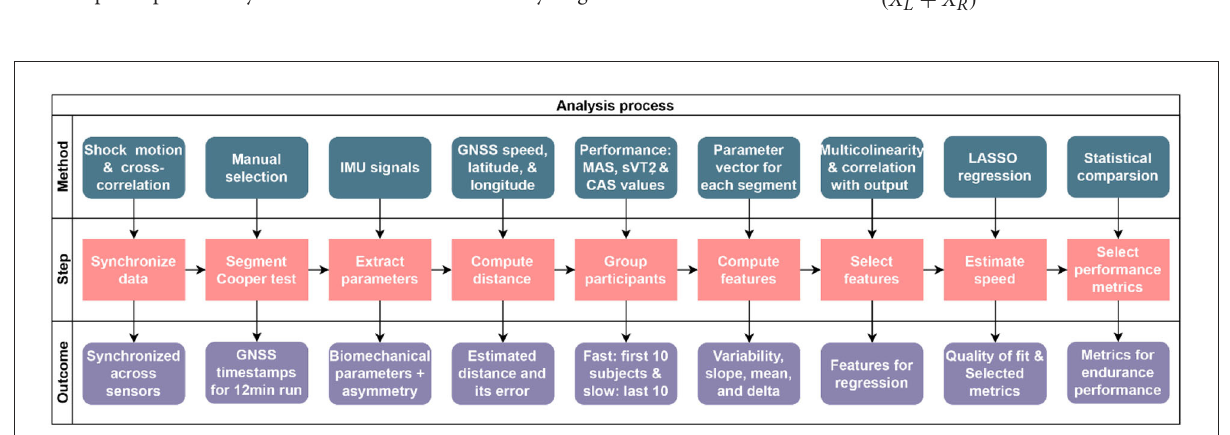
FIGURE2 Flowchart of the overall procedure for extraction and selection of metrics. LASSO, least absolute shrinkage and selection operator; CAS, average speed during the 12-minute Cooper test.